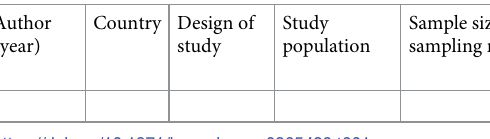
Table 1. Characteristics of included studies